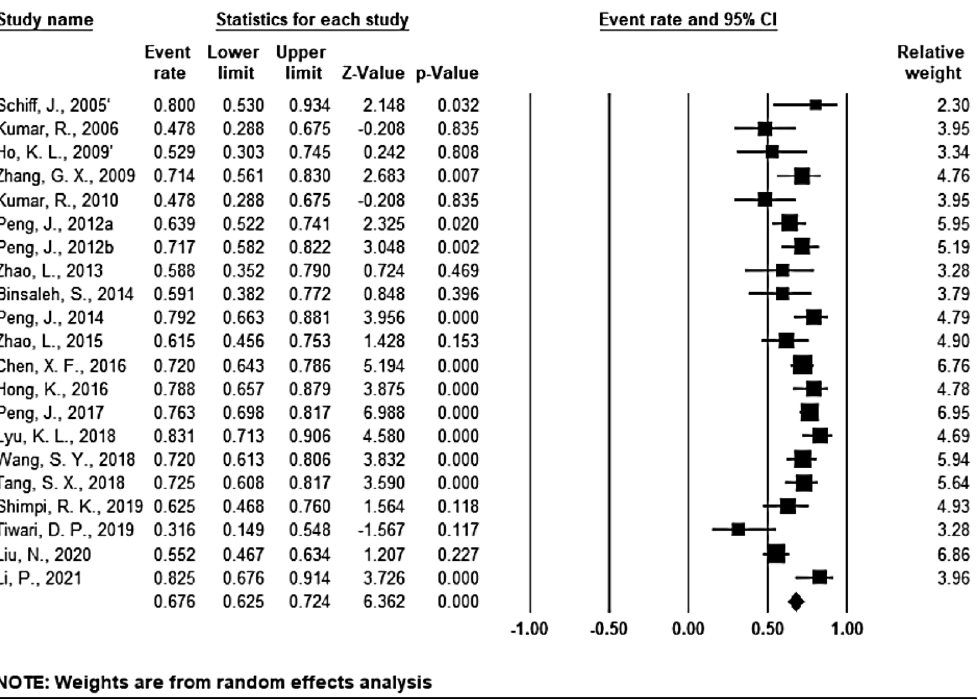
Figure 5. Forest plots of patency rate under LIVE